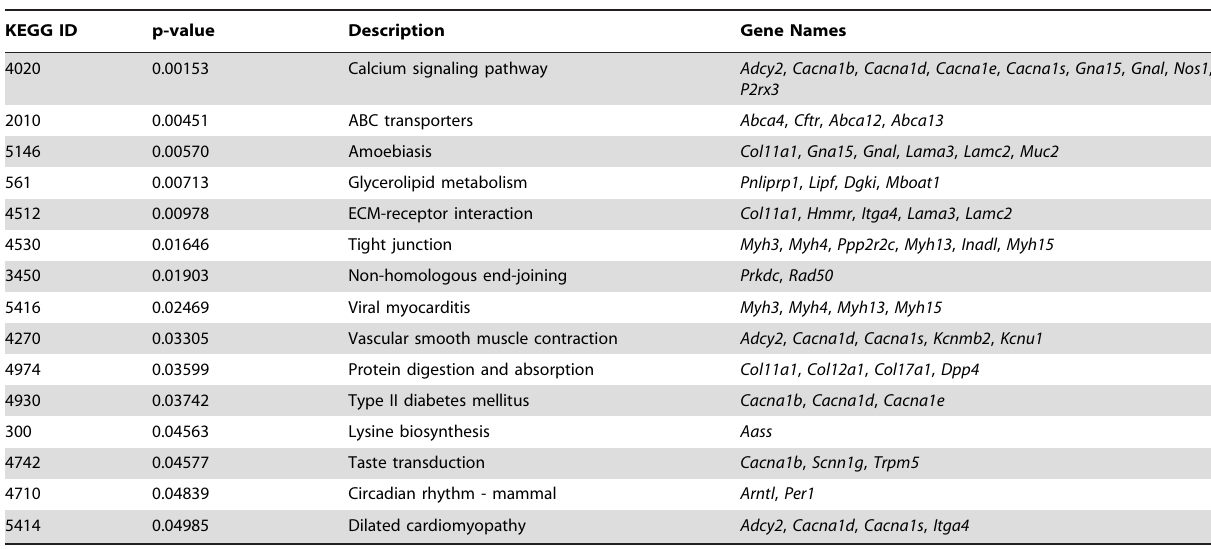
Table 7. Heart pathways